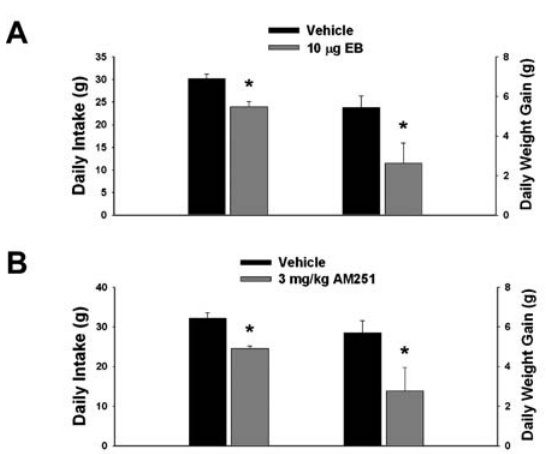
Figure 1. EB ( A ) and AM251 ( B ) decrease food intake and body weight. Bars represent means and vertical lines 1 SEM of the daily food intake and weight gain measured every day for seven days. *, Values measured in EB- and AM251-treated animals that are significantly different (Student’s t-test; p < 0.05; n = 5 − 8) than those measured in vehicle-treated